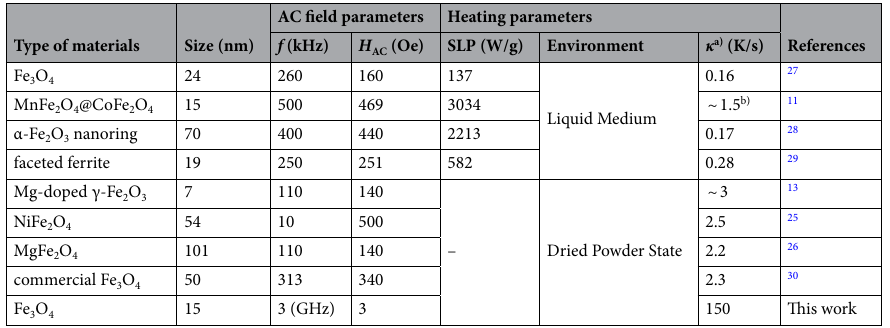
Table 1. Comparison of heating powers (SLP and κ ) reported in literature. a) The values of κ were obtained by measuring the initial slopes of temperature -vs -time curves found in the literature, except for the value of b). b) This value was estimated by a numerical conversion from the SLP value reported in the corresponding